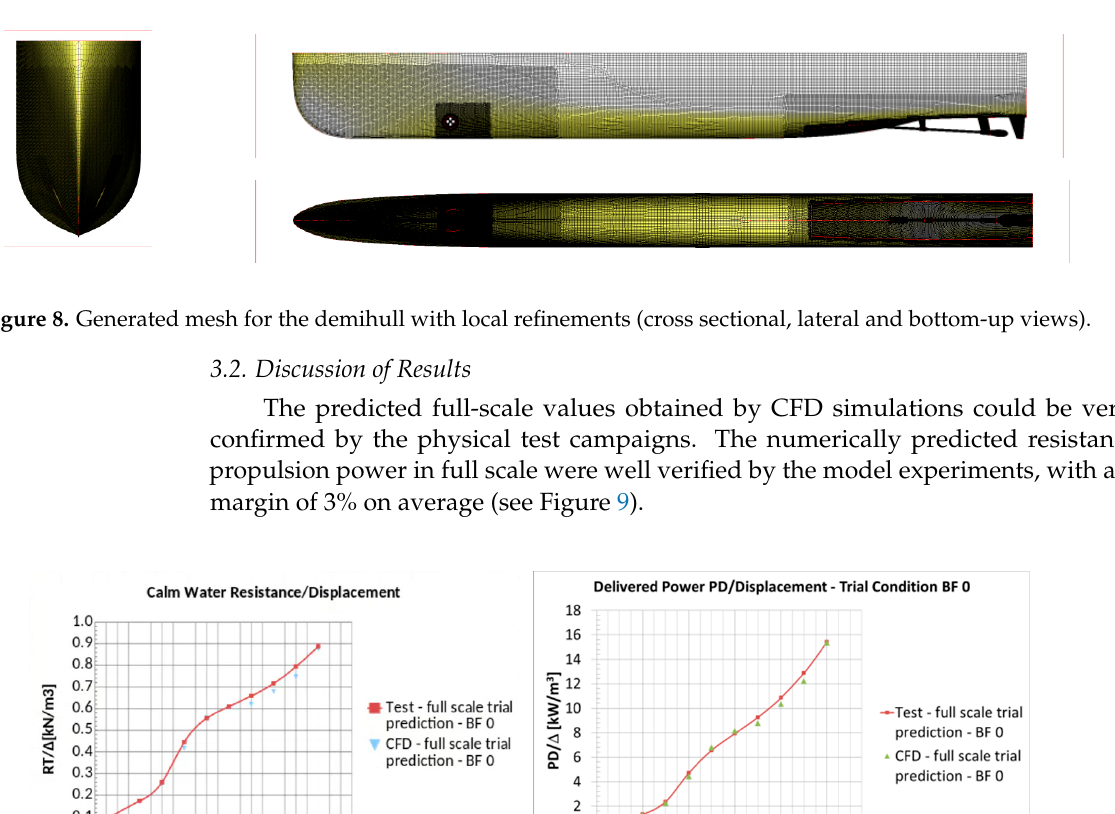
Figure 9 . Comparison on calm water resistance ( left ) and delivered power ( right ) per displace-